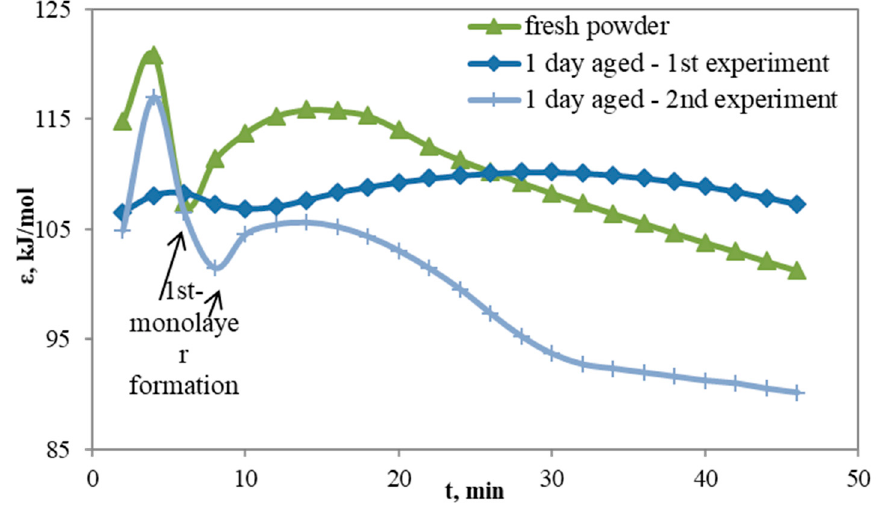
Figure 12. The local adsorption energy of the powdered catalyst samples at 80 °C and the role of aging on their local adsorption energy.